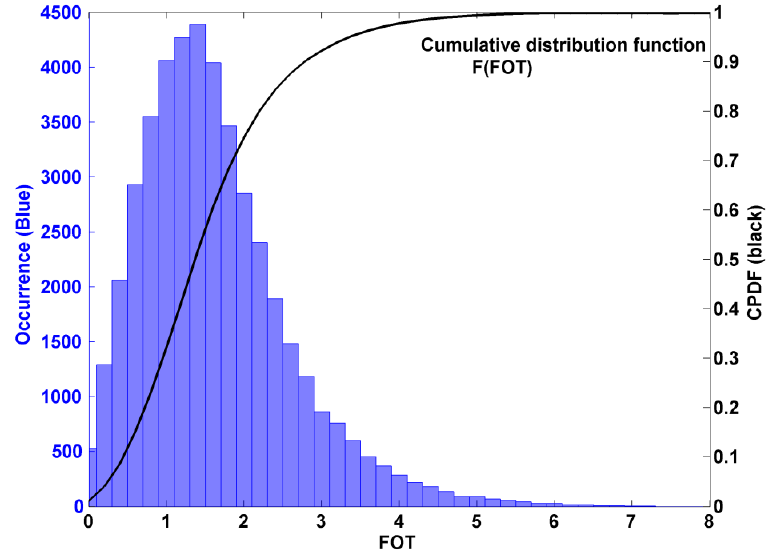
Figure 5. Blue bars: Forest optical thickness ( FOT ) distribution in tropical montane cloud forest (Table 4). Black curve: cumulative probability density functions (CPDF)/Cumulative distribution function F of FOT